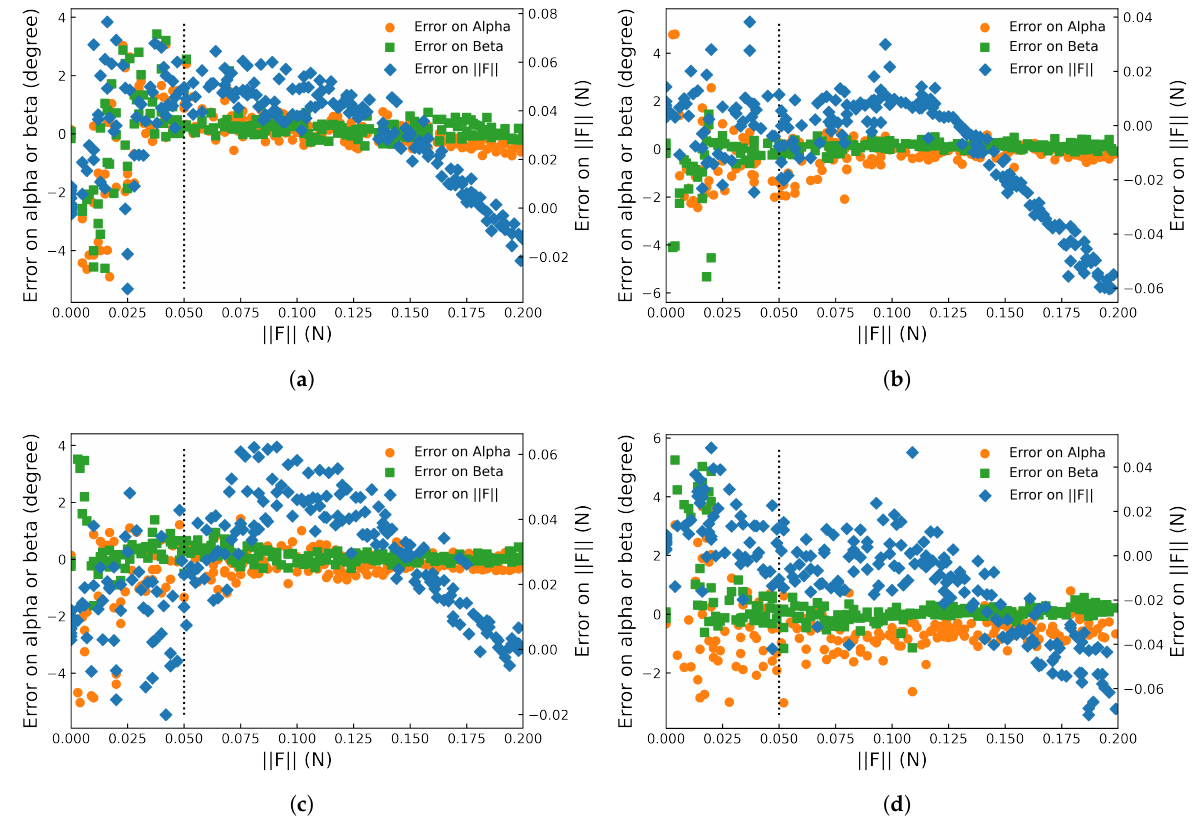
Figure 13. Error in inferring α (orange circle), β (green square), and (cid:107) F (cid:107) (blue diamond) vs. (cid:107) F (cid:107) ∈ [ 0,0.2 ] N at poses ( a ) α = 5 ◦ , β = 4 ◦ , ( b ) α = − 5 ◦ , β = 4 ◦ , ( c ) α = 5 ◦ , β = − 4 ◦ , and ( d ) α = − 5 ◦ , β = − 4 ◦